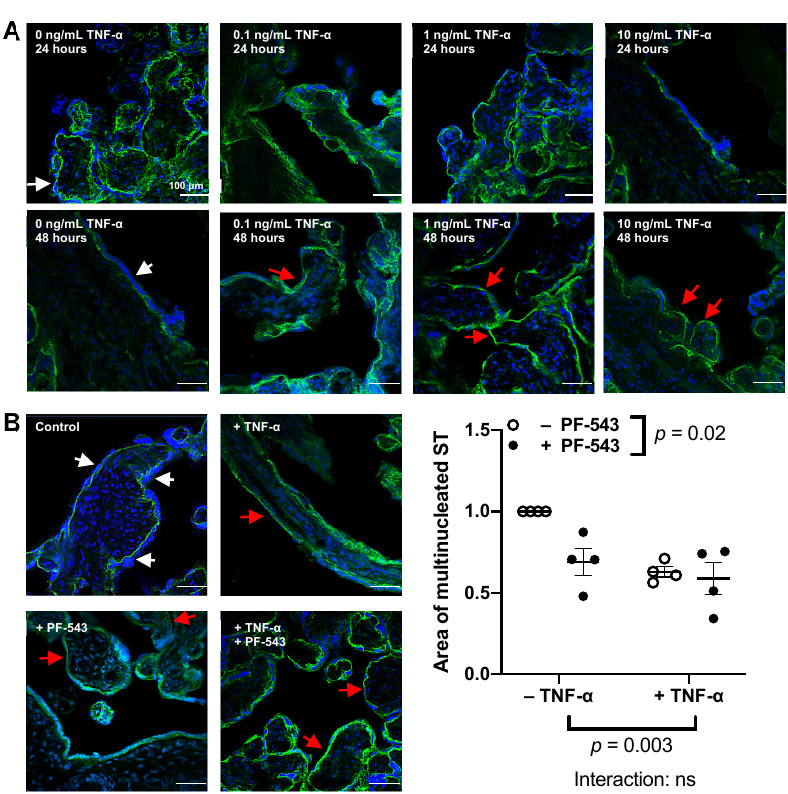
Figure 3. Resyncytialization in term placental chorionic explants from normal pregnancies decreased in response to tumor necrosis factor-alpha (TNF- α ) and SphK1 +inhibition independently. ( A ): Explants were pre-cultured for 4 days prior to treatment to induce syncytial shedding. Resyncytialization of term chorionic explants following treatment with 0–10 ng/mL of TNF- α after 24 or 48 h of treatment was analyzed using confocal fluorescence microscopy. DAPI stained nuclei blue and E-cadherin (AF488) stained adherens junctions green ( n = 3). ( B ): Explants were pre-cultured for 4 days prior to treatment with 1 ng/mL of TNF- α , 1 µ M PF-543, a co-treatment of both or a no- treatment control for 48 h. Results were analyzed by measuring total area of the syncytium and normalizing it to the total surface area of the chorionic explant. Results are presented as relative to the no-treatment control and analyzed by two-way ANOVA with the two-stage linear step-up procedure of Benjamini, Krieger, and Yekutieli post-hoc test. (Mean ± SEM, n = 4). Since 1 ng/mL TNF- α had no significant effects on β -hCG and LDH release, we